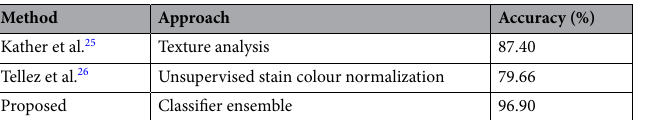
Table 11. Comparison of the proposed ensemble method with some previous methods in literature on the Zenodo 5K dataset used for the additional test in this